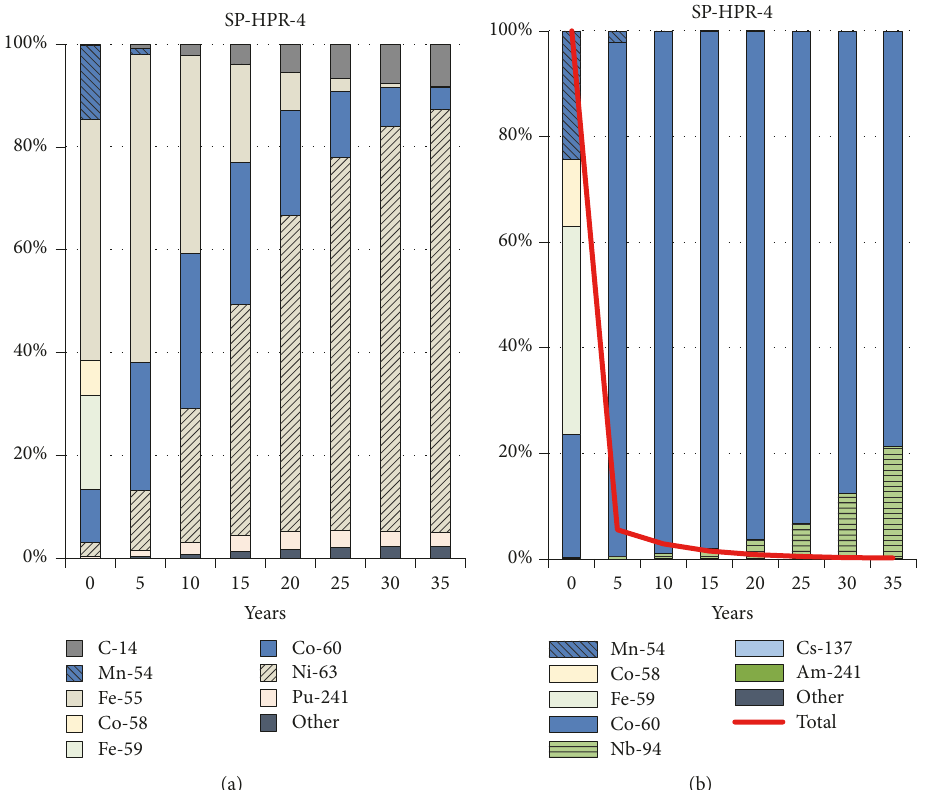
Figure 4: Changes of the relative composition of nuclides for SP-HPR-4 component with time: (a) activity of the deposits; (b) 𝛾 dose rate of the deposits (other < 1%).